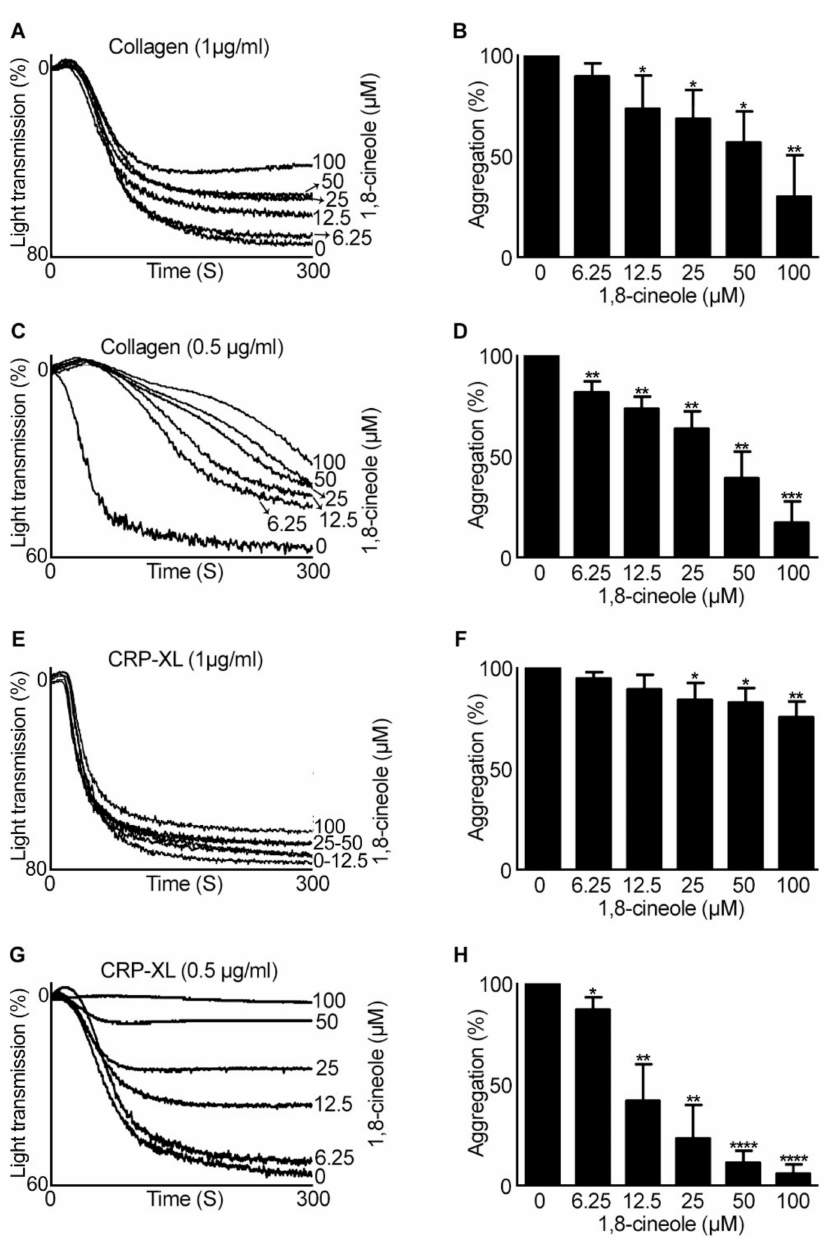
Figure 2. Impact of 1,8-cineole on GPVI agonists-stimulated aggregation in human PRP. Human PRP was treated with a vehicle control [0.1% ( v/v ) ethanol] or various concentrations of 1,8-cineole for 5 min prior to stimulation of aggregation with 1 µ g/mL ( A , B ) or 0.5 µ g/mL ( C , D ) of collagen, and 1 µ g/mL ( E , F ) or 0.5 µ g/mL ( G , H ) of CRP-XL. The level of aggregation was monitored for 5 min by optical aggregometry. The aggregation traces shown are representative of five separate experiments. The percentage of aggregation for 1,8-cineole-treated samples was calculated by considering the level of aggregation obtained with the vehicle control (0) as 100%. Data represent mean ± SEM ( n = 5). The p values shown (* p < 0.05, ** p < 0.01, *** p < 0.001 and **** p < 0.0001) are as calculated by one-way ANOVA followed by Bonferroni post hoc